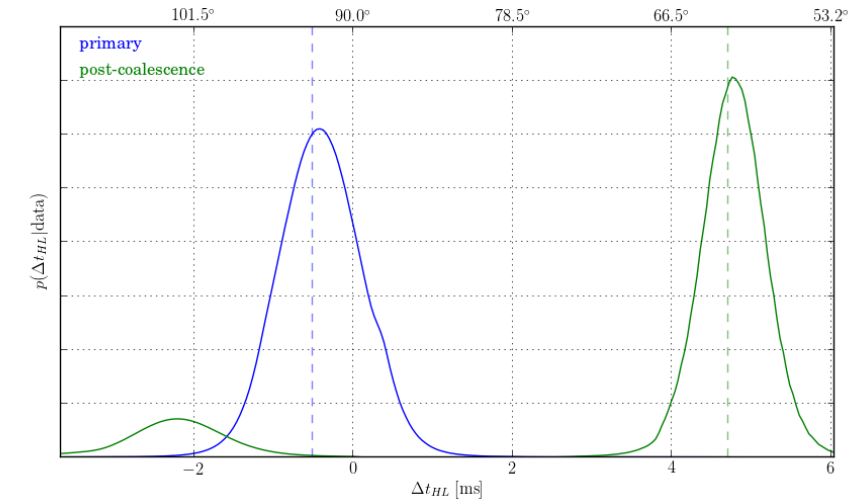
Figure 34. Maximum posteriori probability for time delay between Hanford (H) and Livingston (L) in line-of-sight frame for the main event GW151012 (blue contour) and the secondary signal (green contour) FIG. 4. Left panel: Mollweide projection of GW151012 primary event (blue contour lines) and the secondary event (green lines) sky reconstructions in equatorial coordinates (a). Right panel: time delay maximum a posteriori probability marginals between H and L in line-of-sight frame defined by H and L (b). Both figures have been produced using the code in [24].